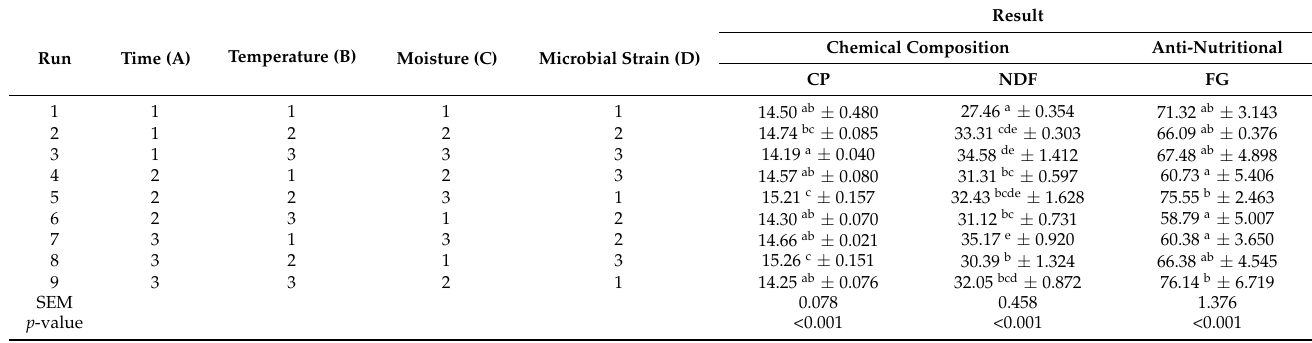
Table 9. Orthogonal results of fermentation test with multi factors of TMR with CSM.